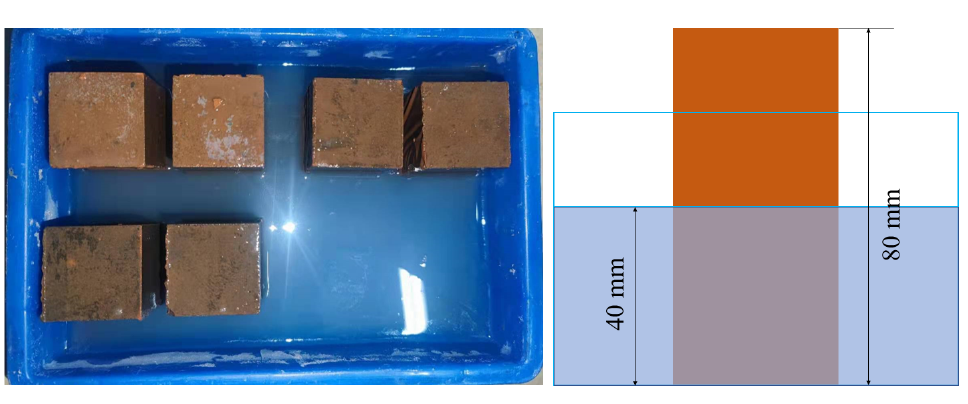
Figure 4. Efflorescence test.